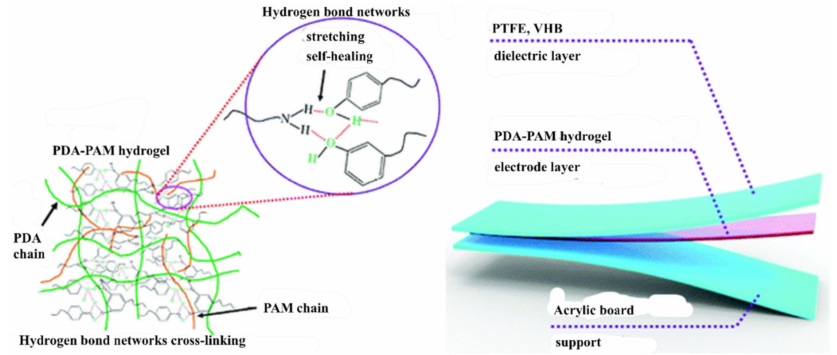
Figure 1. The mechanism of the hydrogel’s self-healing properties and design of TENG. Reproduced from [104] with permission from The Royal Society of Chemistry.